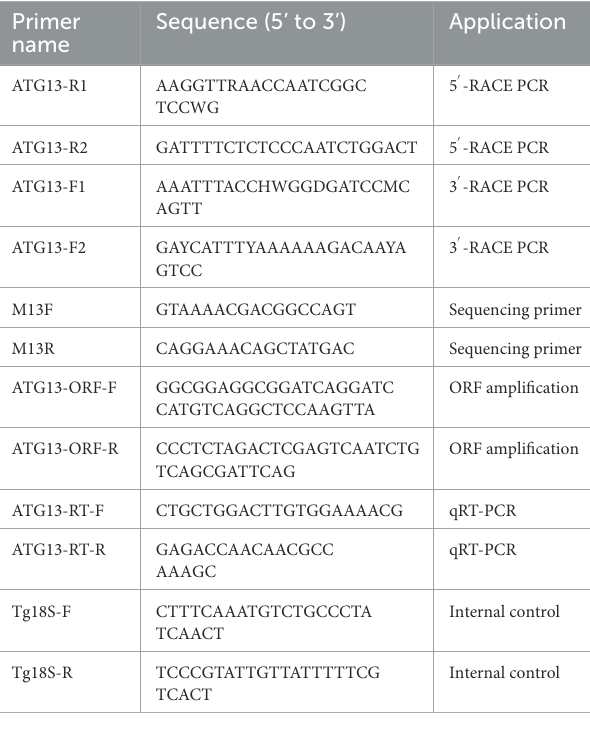
TABLE 1 Primers used in this